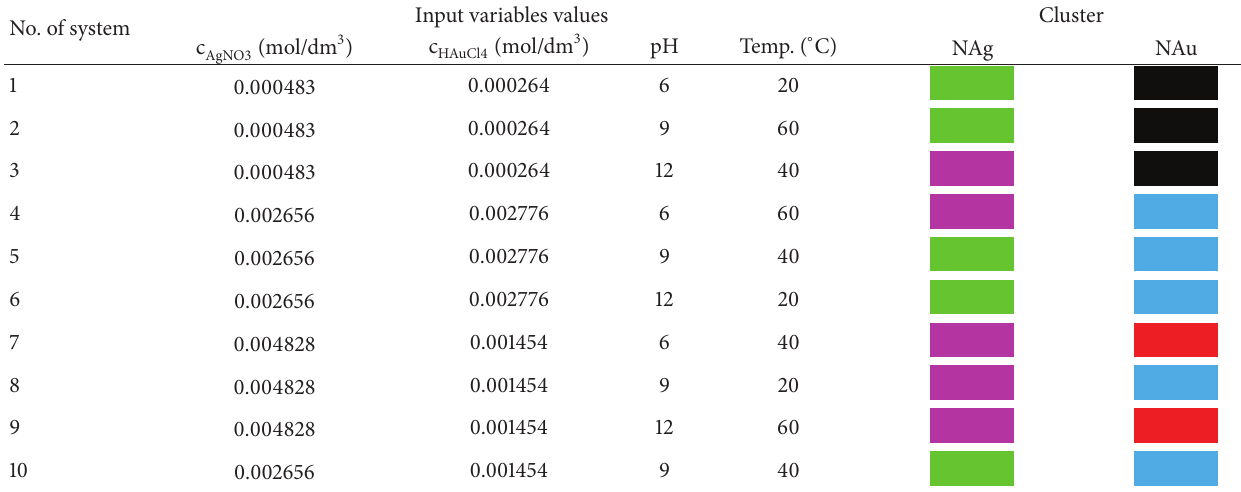
Table 4: Matrix of the fractional plan for obtaining nanosilver and nanogold.